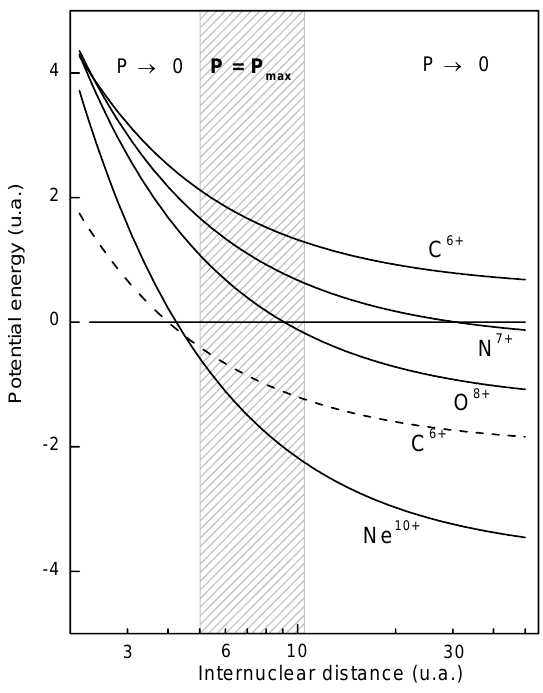
Z+ + He (Z = 6, 7, 8 and 10) in the